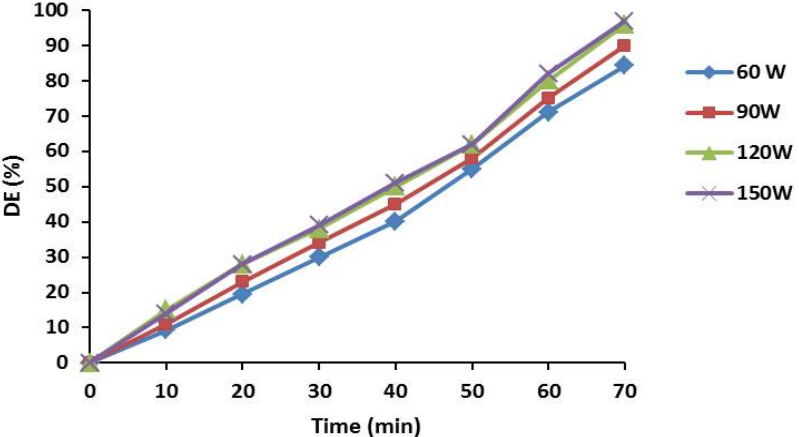
Figure 17. Ultrasound power effect on the degrading RB 19 by diatomite coated 6% Eu-doped Y 2 O 3 . [Catalyst] = 1.25 g/L, pH = 6 and [dye] = 20 mg/L.